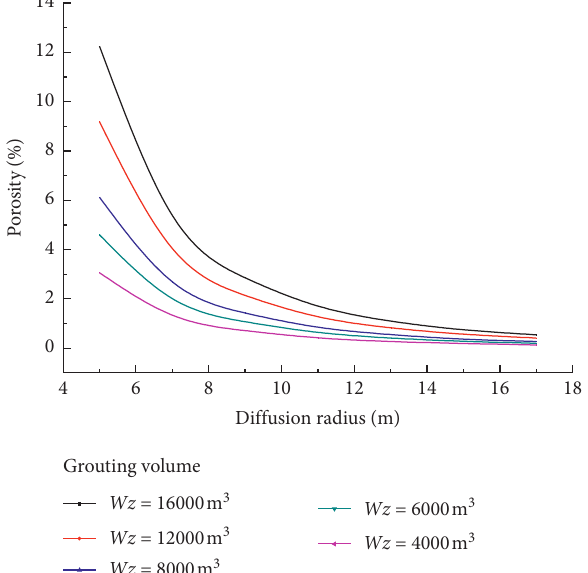
Figure 11: Grouting diffusion radius versus the